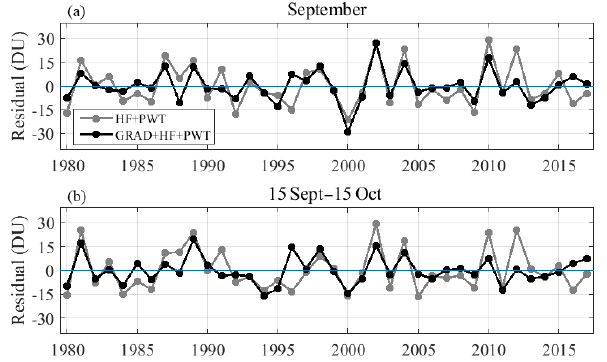
Figure 10. Residual (in DU) with and without contribution of GRAD proxy for September (a) and 15 September–15 October pe- riod (b) .